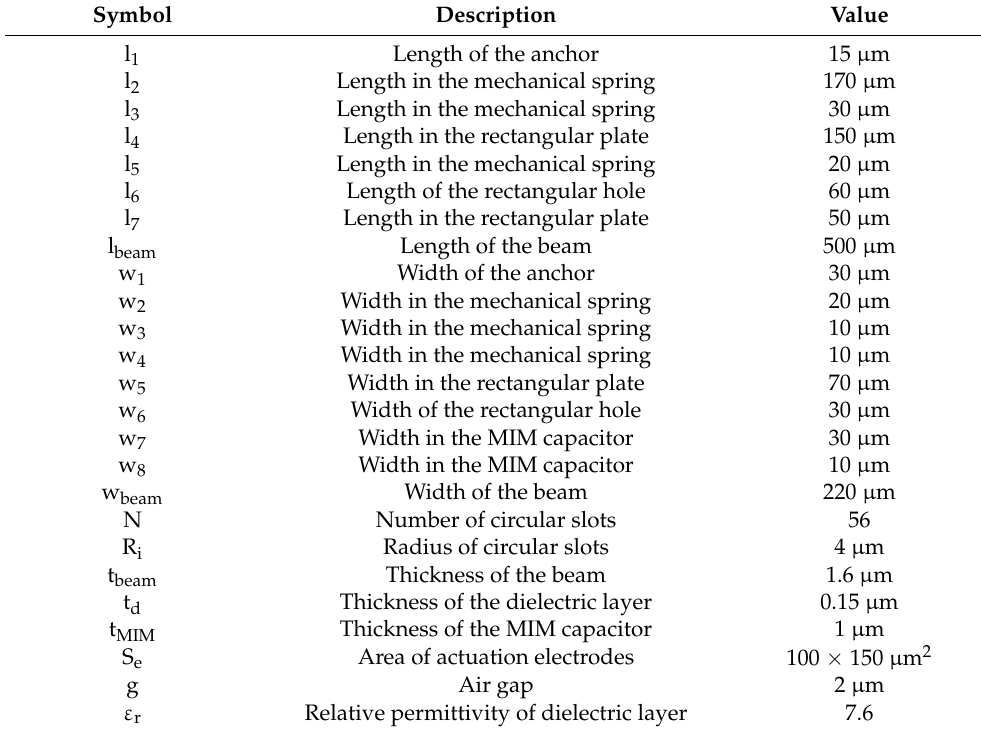
Table 2. Physical dimensions of the switch